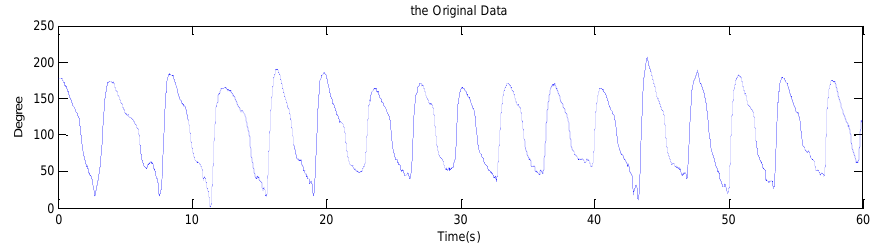
After Wavelet Filter Figure 10. Normal breathing pattern from digital respiratory Figure 10. Normal breathing pattern from digital respiratory sensor. Figure 10. Normal breathing pattern from digital respiratory sensor. Figure 10. Normal breathing pattern from digital respiratory sensor.